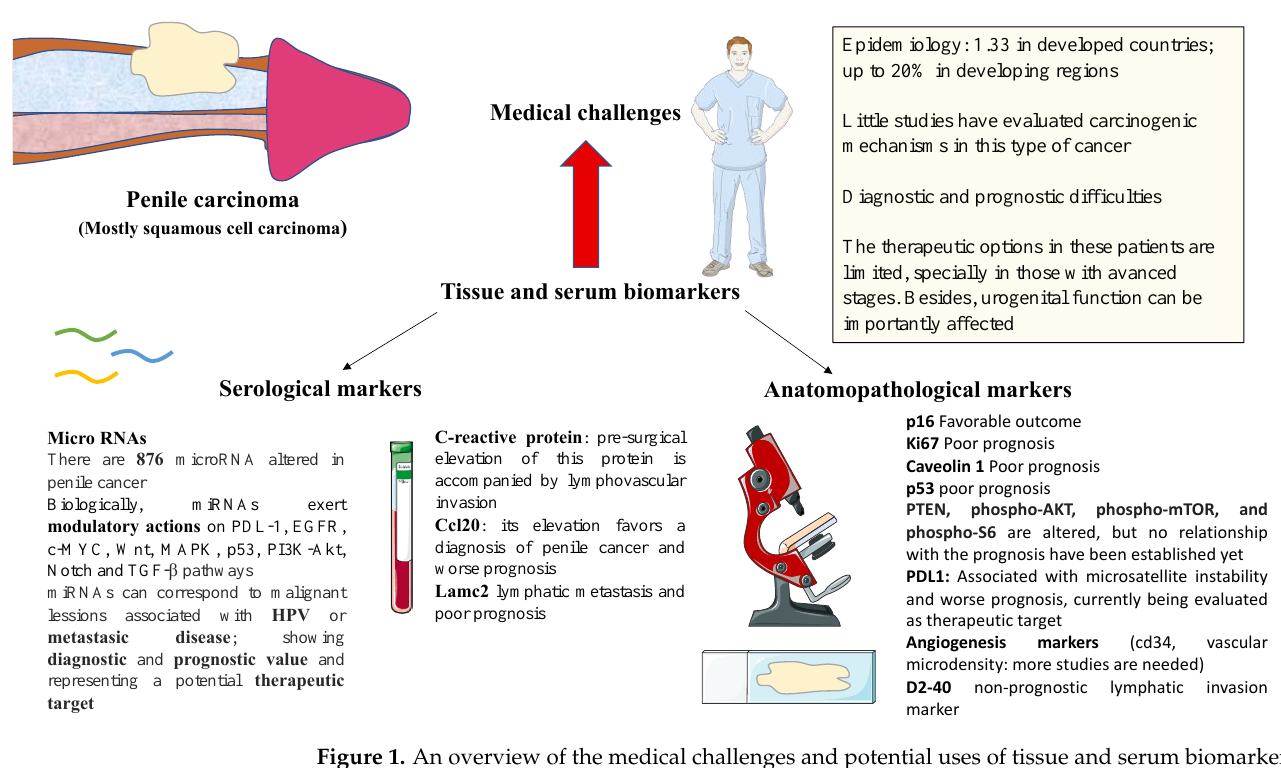
Figure 1. An overview of the medical challenges and potential uses of tissue and serum biomarkers.